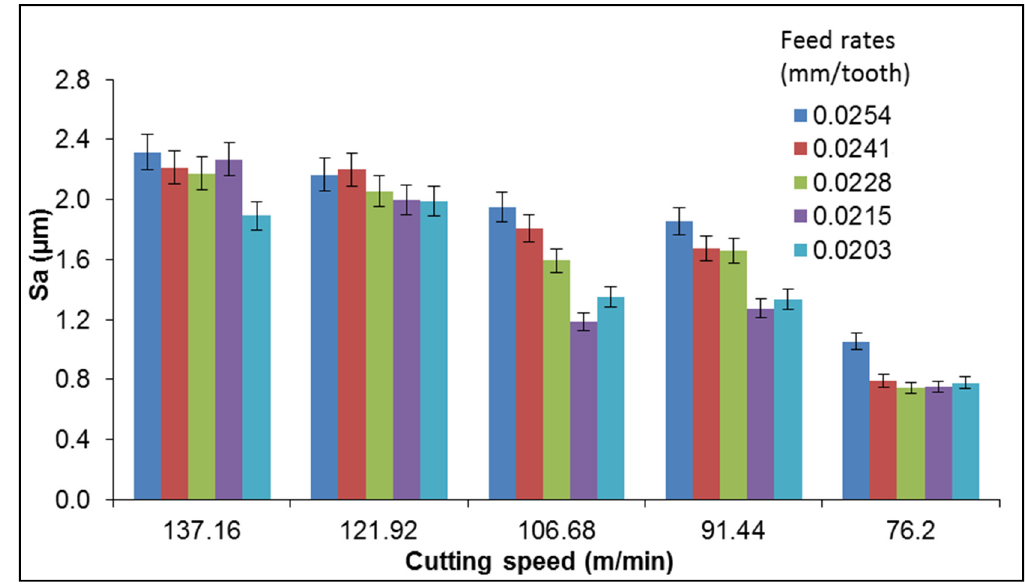
Figure 10. Surface roughness ( Sa ) vs. cutting speed and feed rate for the RS Al–50%Si alloy (Tool 3).